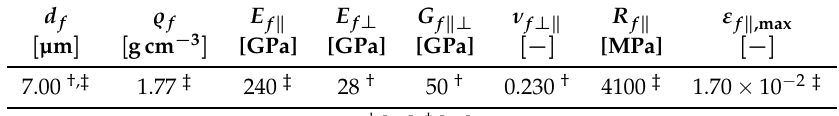
Table 2. Selected properties of a T ENAX R (cid:13) HTA filament